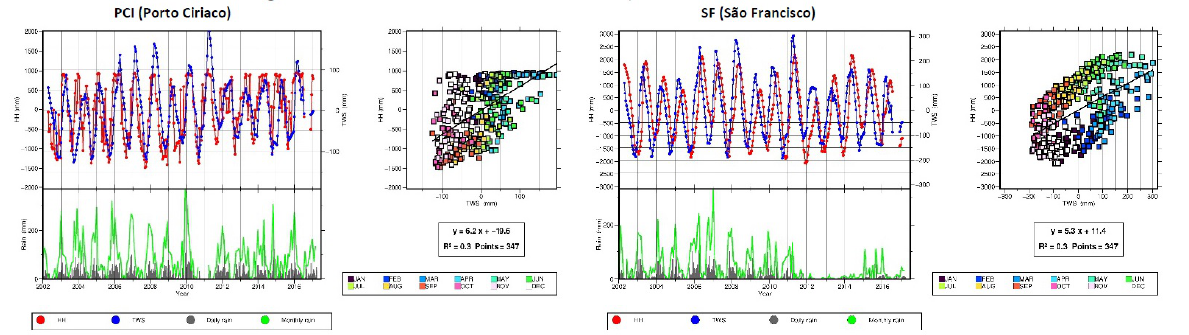
Fig. 10. Time series, determination coefficient and adjustment line, and monthly TWS-HH connection for two river gauge stations selected in the Pantanal area (Mato Grosso do Sul State), period 01/2002-